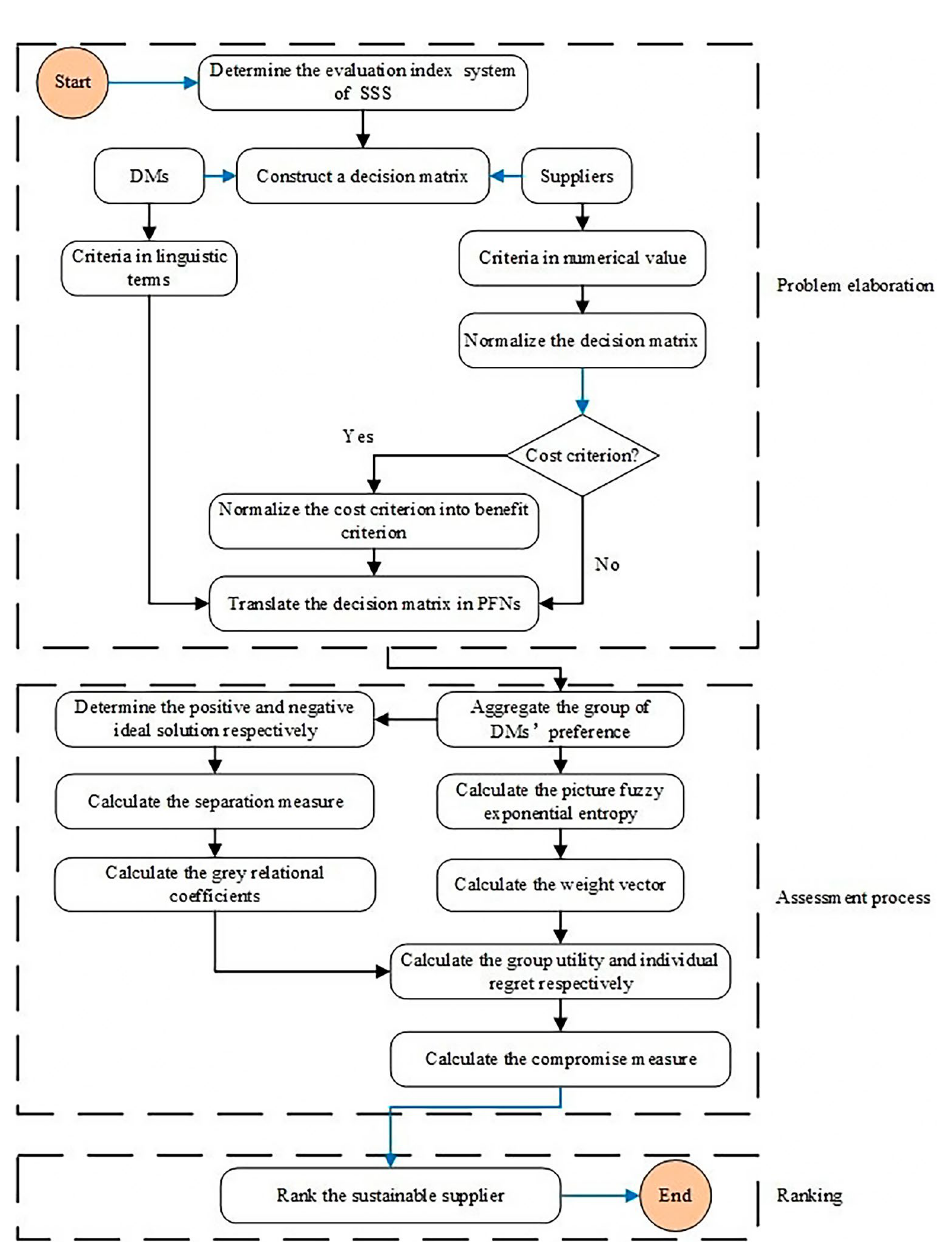
Figure 1. The chart of proposed MCDM framework for